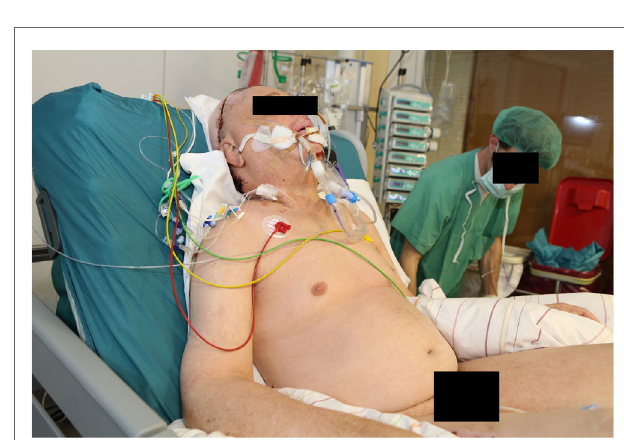
FiGURe 13 | The calvarial defect was closed with a custom-made methyl acrylate implant . Note the anatomical landmarks and the outline of the planned skin paddle of the parascapular flap.